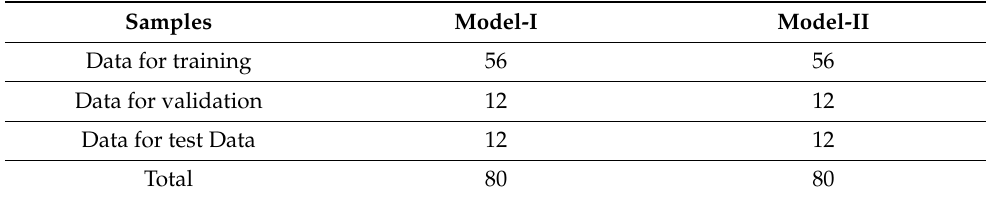
Table 2. Data description for ANN models.